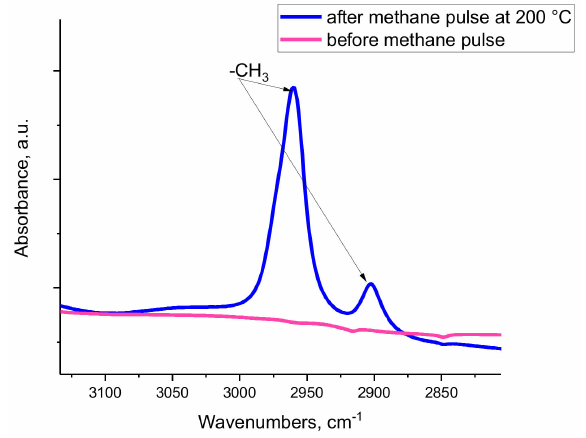
Figure 6. FTIR spectra showing the C-H stretching region of dehydroxylated gamma alumina before and after methane exposure (~0.5 Torr total pressure of methane) at 200 ◦ C. The bands that developed correspond to two IR active vibrations of a methyl